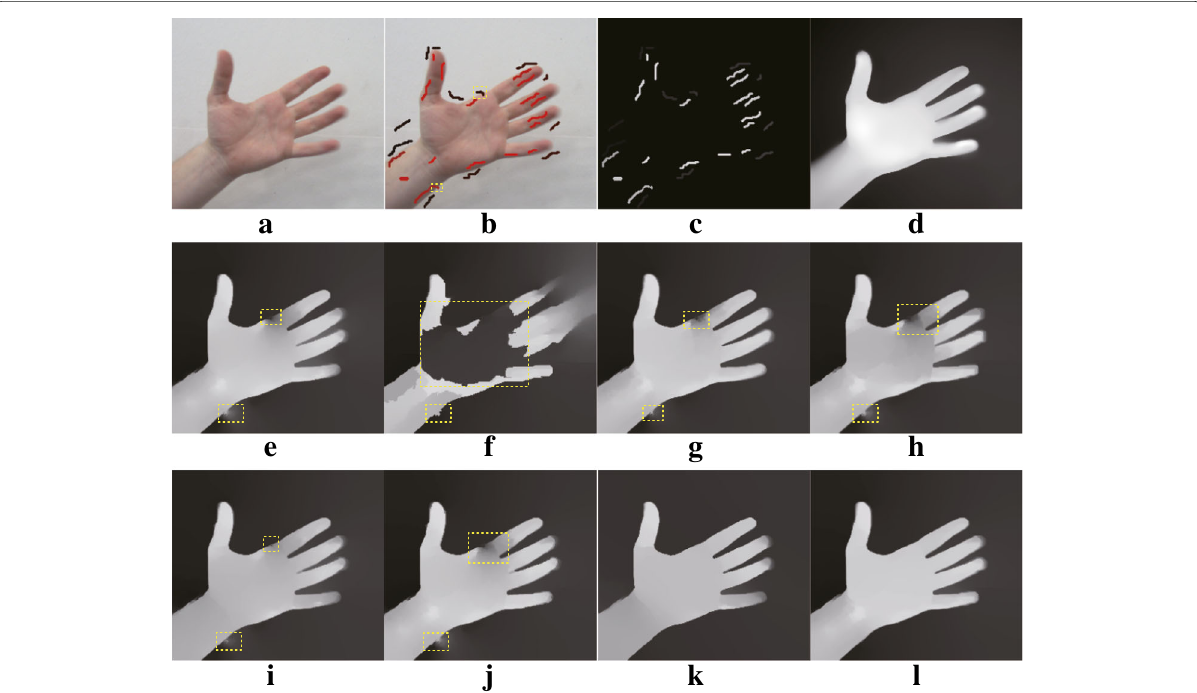
Fig. 12 Results of RGBZ_09 with cross-boundary input. a Input image. b User-labeled image. c Sparse depth. d Groundtruth depth. e Depth of RW. f Depth of HGR. g Depth of NRW. h Depth of OPT. i Depth of OCP. j Depth of SDF. k Depth of (cid:2) 1 . l Depth of the proposed method. Please zoom in to see